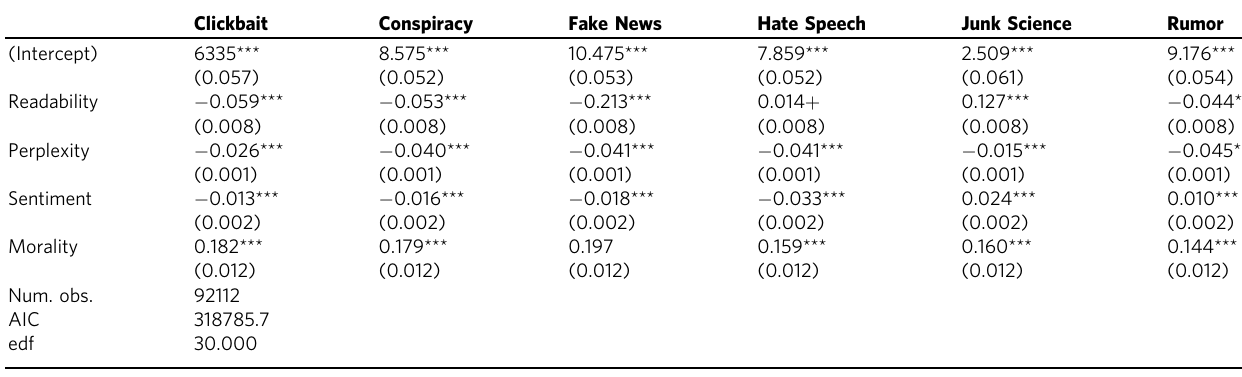
Table 3 Quantitative differences among factual news and misinformation